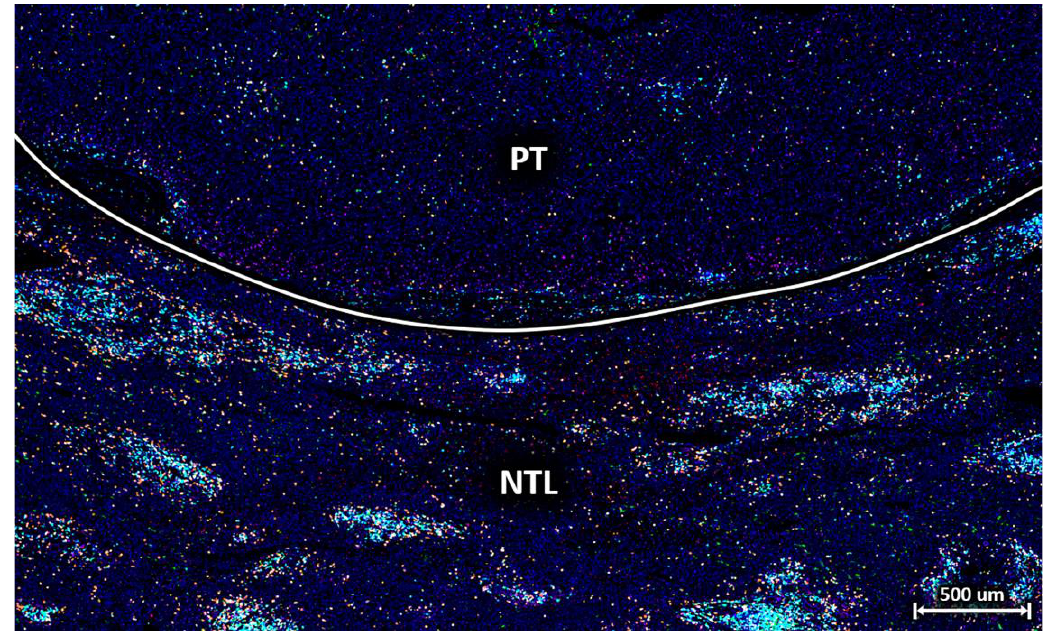
Figure 2. Exemplary section of a multiplex-stained tissue sample with HCC primary tumour (PT) tissue on top and non-tumour liver (NTL) tissue on the bottom. Labelling for nuclei with DAPI (blue), T cells with CD3 (turquoise), T helper cells with CD4 (green), cytotoxic T cells with CD8 (orange), PD-L1 (red), and regulatory T cells with FoxP3 (magenta). The liver parenchyma in the vicinity of the HCC contains several clusters of T cells consisting mainly of T helper cells, cytotoxic T cells, and regulatory T